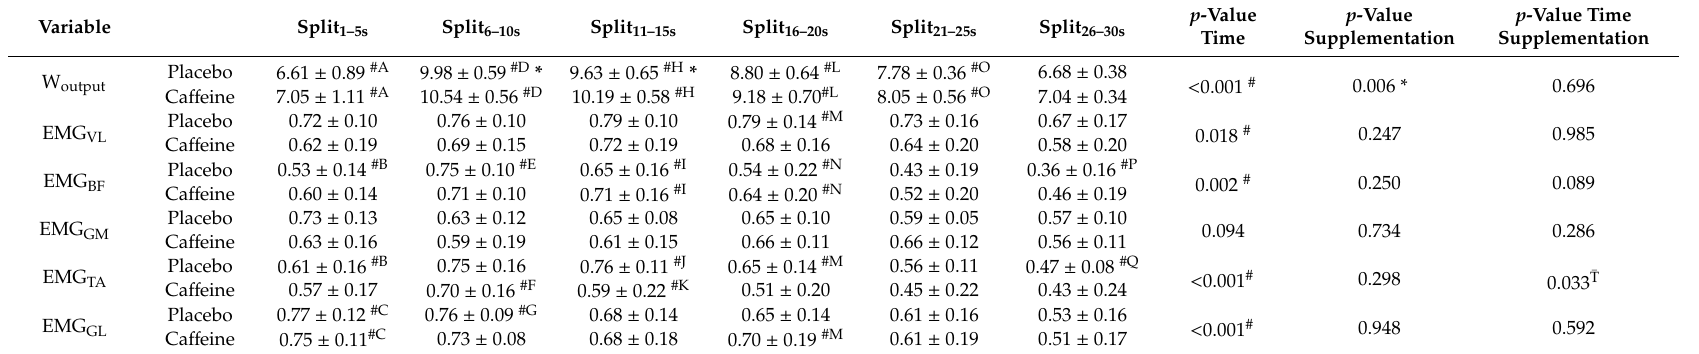
Table 2. Mean and standard deviations (SD) of power output and rms-EMG data during 6 splits in the Wingate